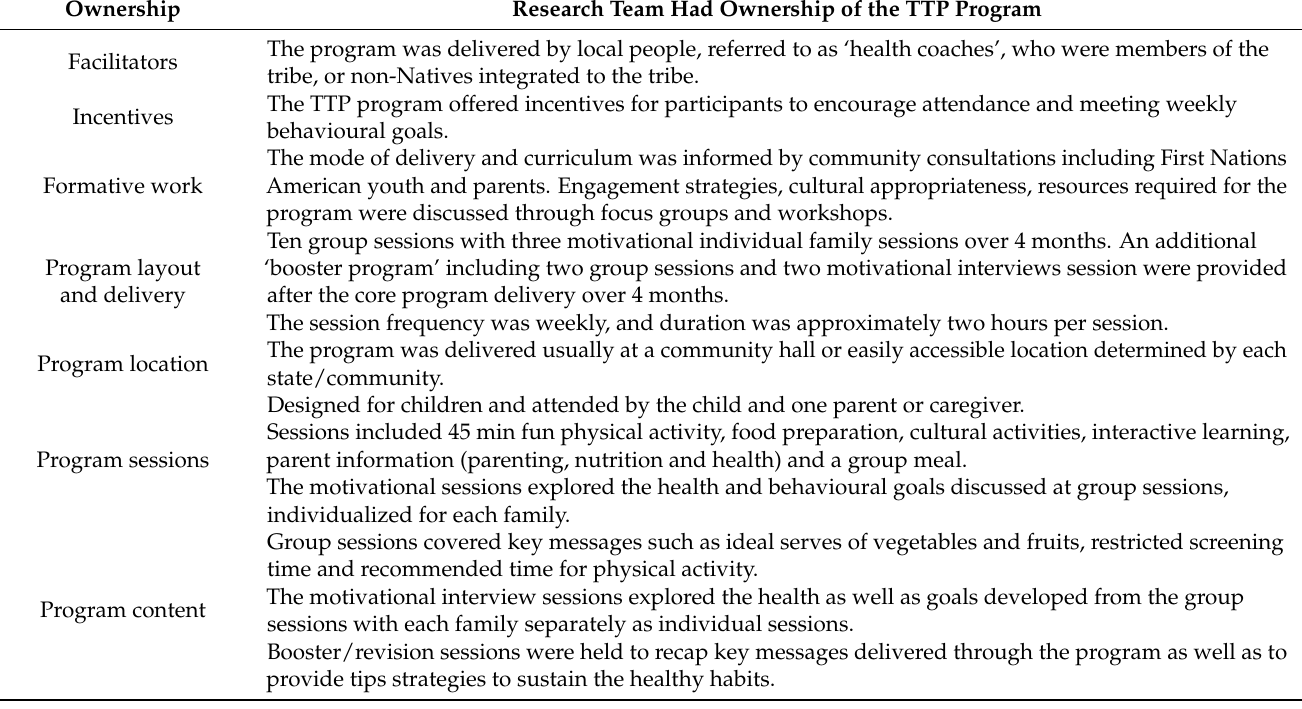
Table 1. Key characteristics of the original Tribal Turning Point